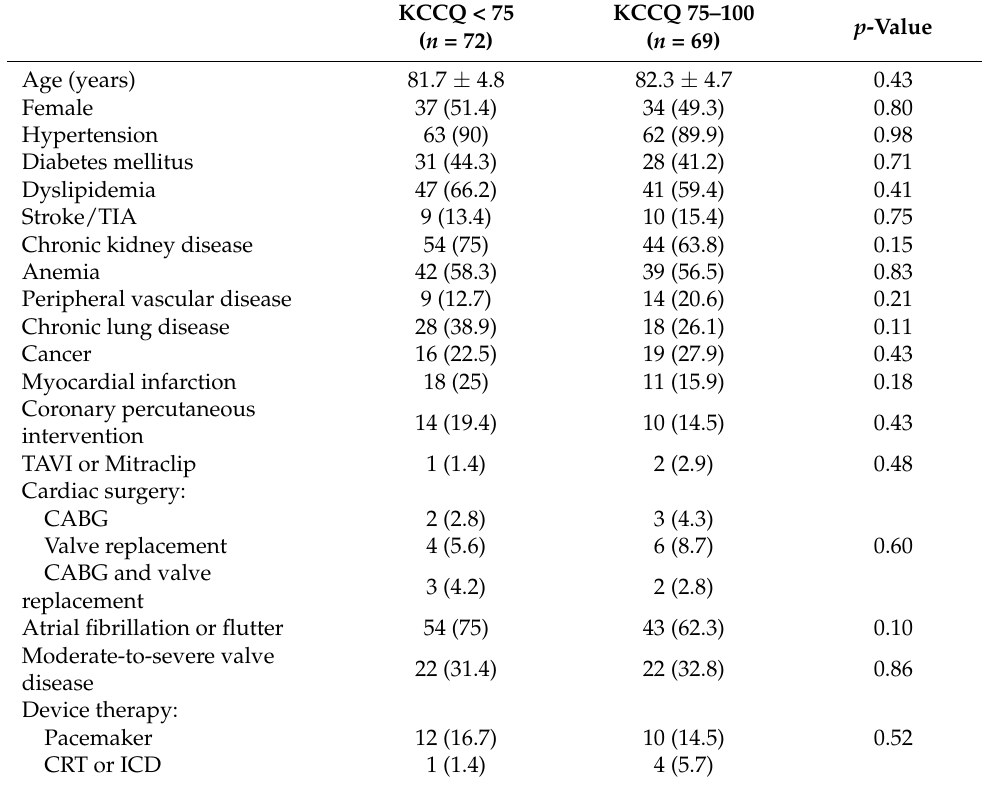
Table 1. Baseline clinical and demographic characteristics of the patients included in the